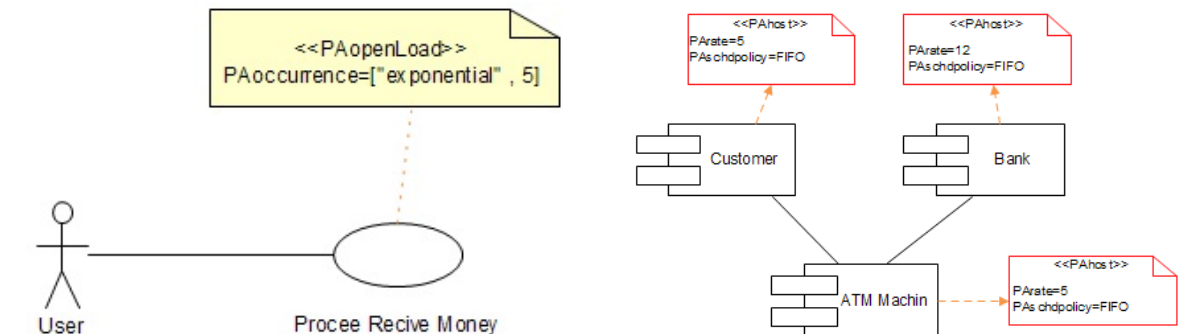
Fig. 1. use case relevant to action diagram Fig. 2. The component diagram with annotation